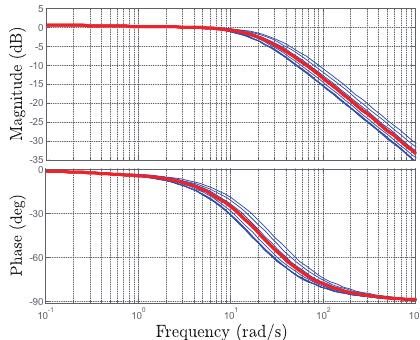
Figure 8. Bode diagrams of the identified linear dynamics models where the red line corresponds to the nominal